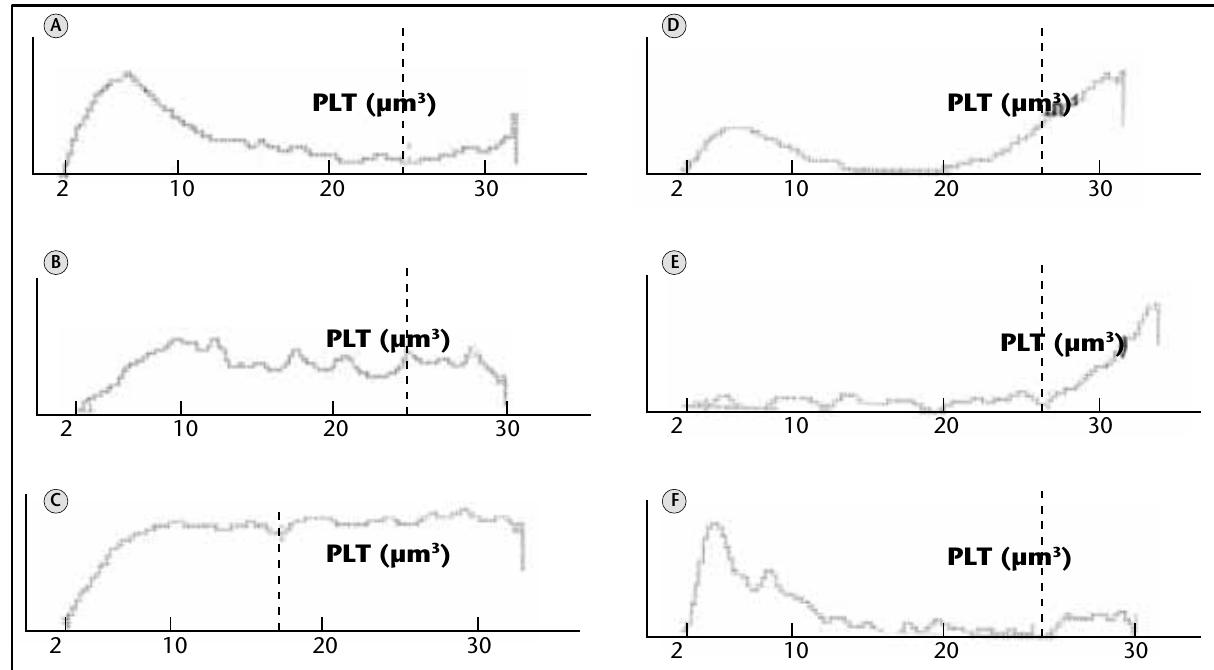
Figura 3 – Histogramas plaquetários mostrando interferentes: eritrócitos fragmentados (a, b) , micrócitos (C) , macroplaquetas (d, e) , fragmentos de células leucêmicas (F) (Pentra DX 120